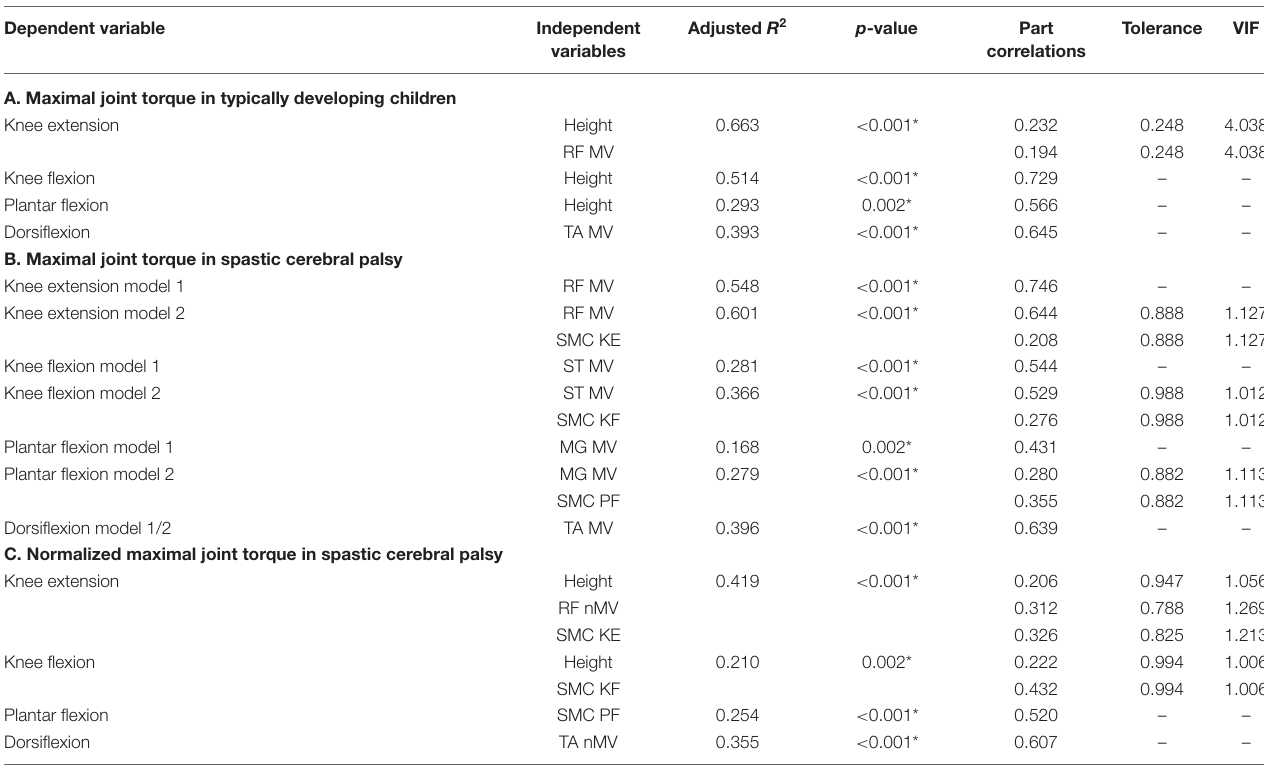
TABLE 4 | Regressions best fit.